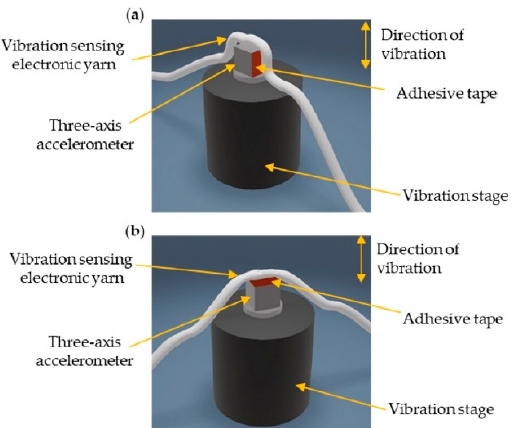
Figure 2. Schematic of the experimental set-up of the vibration-sensing E-yarn connected to the vibration stage. ( a ) Orientated for testing the x-axis response of the E-yarn. ( b ) Orientated for testing the z-axis response of the E-yarn.